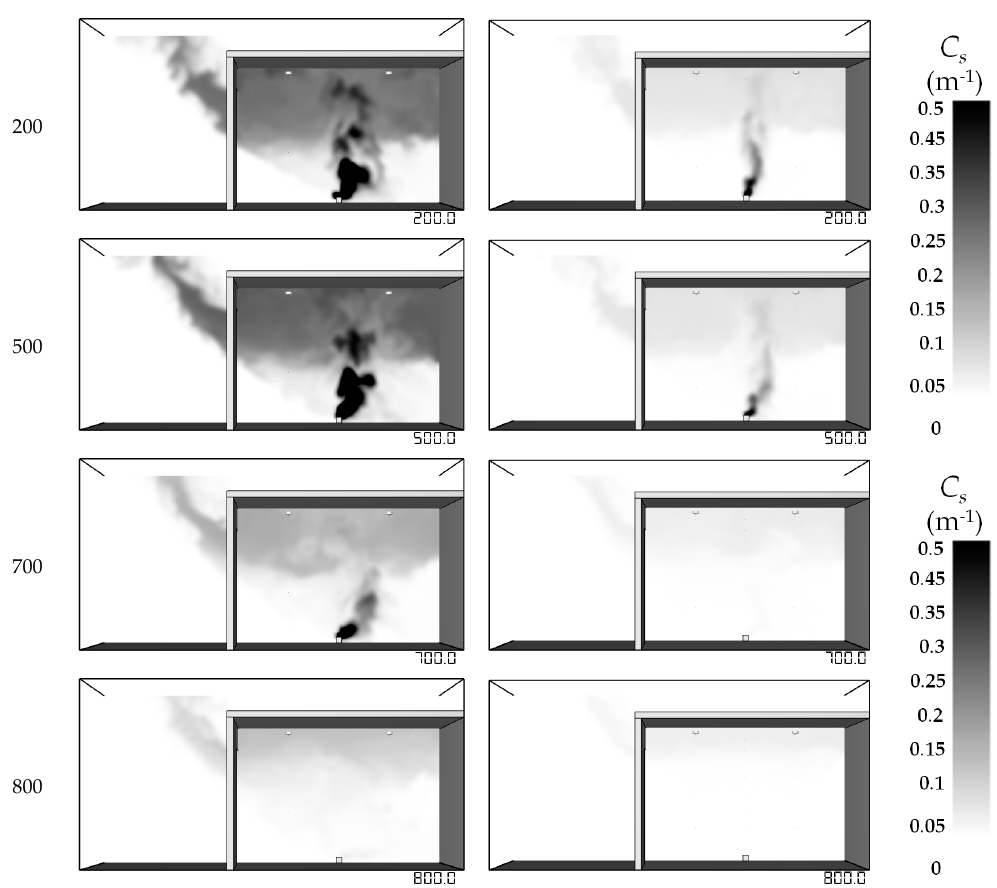
Figure 8. Calculated C s with the measured K m and M s for each of the polymers as a function of time.